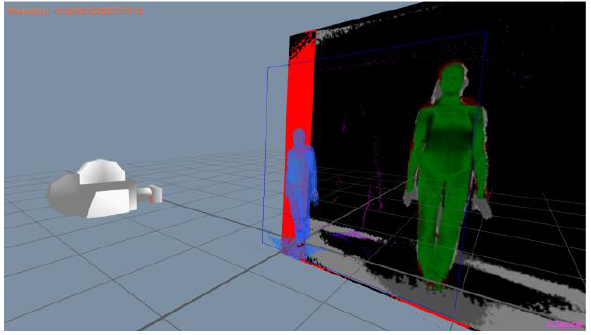
mismatch number. The lowest the number, the better the match.